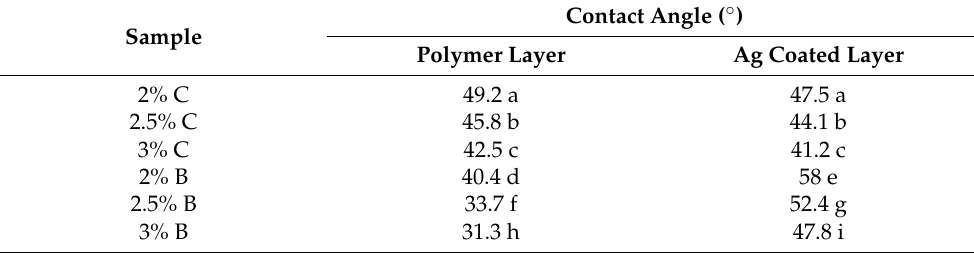
Figure 4. ( a ) Contact Angle Measurements of bilayer and composite Films, polymer layer, and silver Coating, ( b ) Images of the drop on the surfaces of the films. Table 3. Contact angles of water for Ag coated and polymer